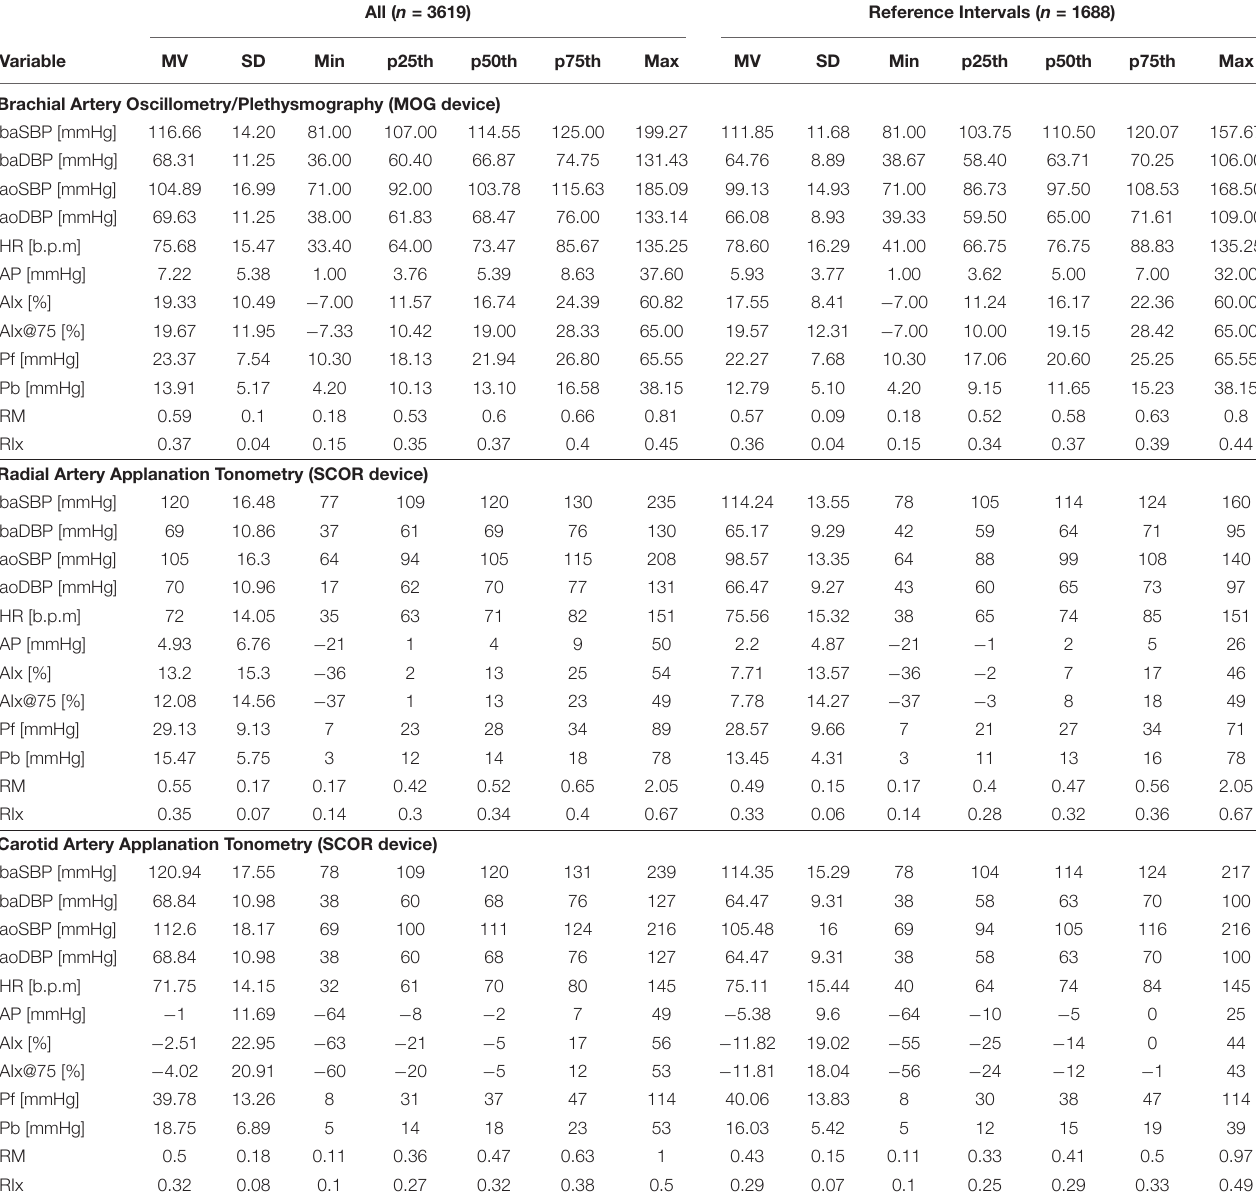
TABLE 2 | Central and peripheral blood pressure and central waveform-derived indexes. All ( n =